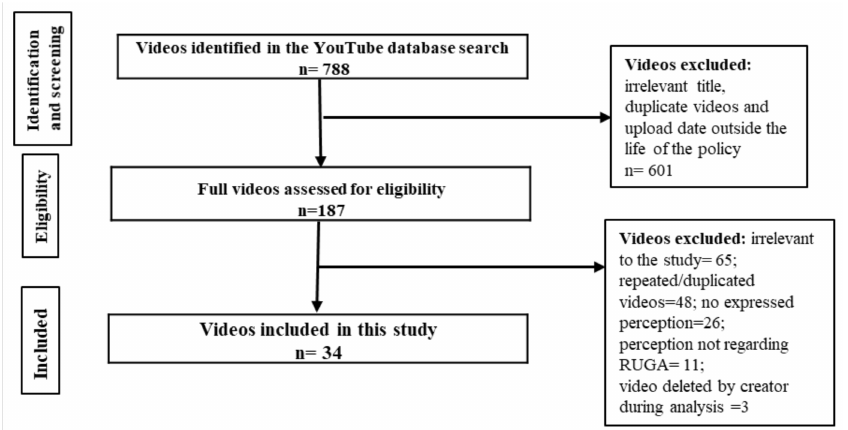
Figure 2. Flow diagram of the YouTube video selection